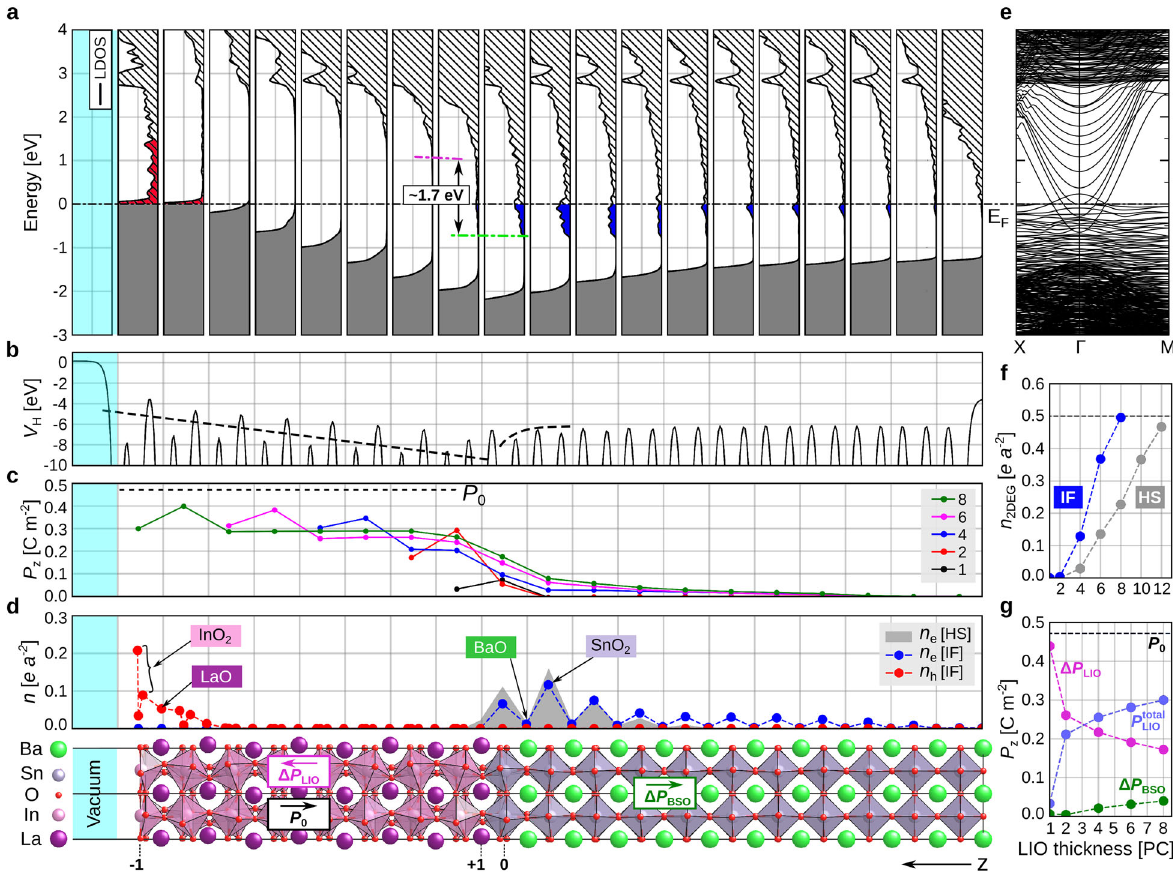
Fig. 3 Stoichiometric non-periodic interface (here termed IF). The system is formed by LIO 8 /BSO 11 in out-of-plane direction z (bottom), which is shared between panels (a – d) as their horizontal axis. P 0 is the formal polarization oriented from the (InO 2 ) − 1 plane towards the (LaO) + 1 plane at the interface. a Local density of states per unit cell (LDOS) with the Fermi level being set to zero (also in panel ( e )). The shaded gray area indicates the occupied valence states. The depleted valence-band region (holes) and the occupied conduction-band region (electrons) resulting from electronic reconstruction, are highlighted by red and blue color, respectively. The dashed green and pink lines indicate the alignment of the conduction-band edges of the two materials at the interface. b In-plane averaged electrostatic potential along the z direction. c Total polarization per unit cell computed for different LaInO 3 thicknesses (in units of the pseudocubic unit cell, PC). d Distribution of the electron (hole) charge densities obtained by integrating the LDOS indicated by blue (red) color in panel ( a ). For comparison, the 2DEG distribution in the periodic heterostructure LIO 12 /BSO 10 (here termed HS) is shown by the shaded gray area. e Electronic band structure along X- Γ -M. f Density of the 2DEG in e per a 2 in the non-periodic (blue) and periodic (gray) heterostructures. g Total polarization ( P LIO , violet) within the LaInO 3 side and changes of polar distortions within LaInO 3 ( Δ P LIO , magenta) and BaSnO 3 ( Δ P BSO , total green) side as a function of LaInO 3 thickness. The respective orientations are shown in the structural